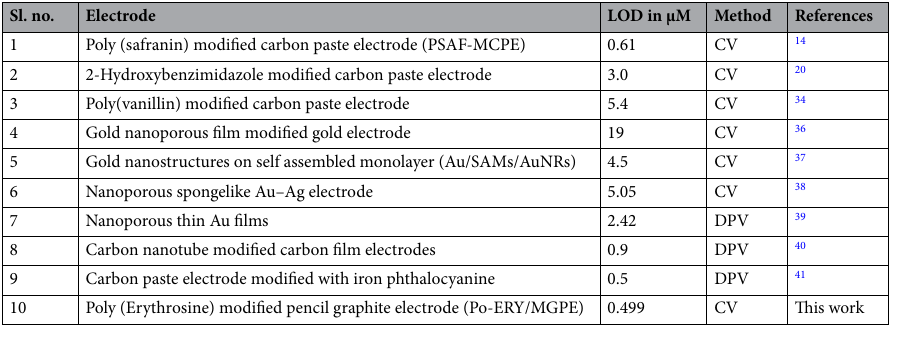
Table 1. LOD of the proposed electrode in comparison to earlier ADR sensors.